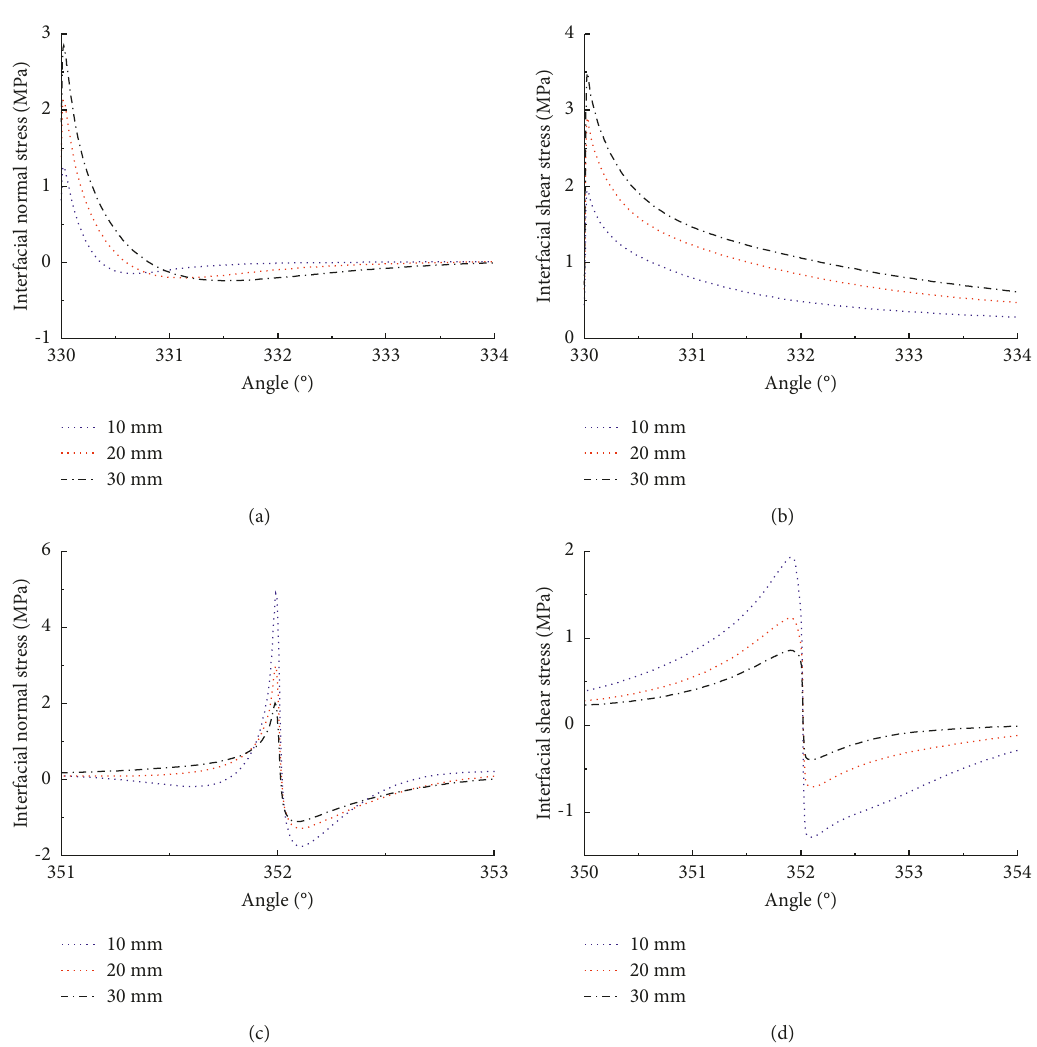
Figure 13: Interfacial stresses under steel plates with different thicknesses. (a) Normal stress near plate end. (b) Shear stress near plate end. (c) Normal stress near 352 ° joint. (d) Shear stress near 352 °